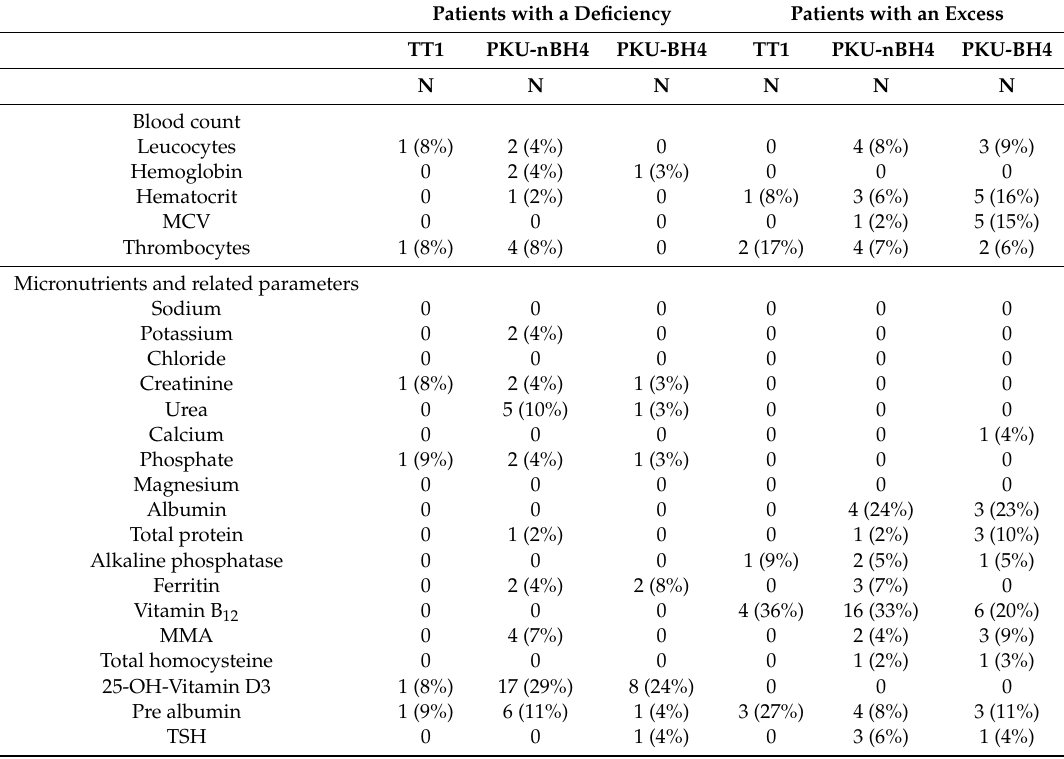
Table 2. Percentage of patients within the different patient groups with too low/deficient blood concentrations, and too high/excessive concentrations. Percentages are included when the N > 0.